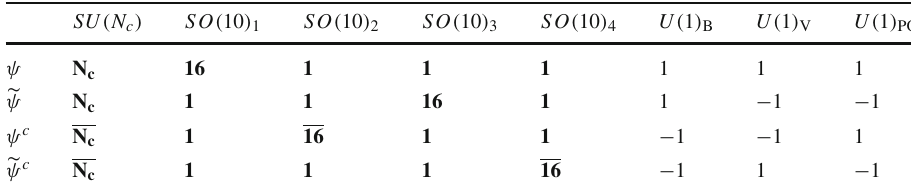
Table 3 Accidental U ( 1 ) global symmetries of the fields of Table 2 arising below the GUT scale